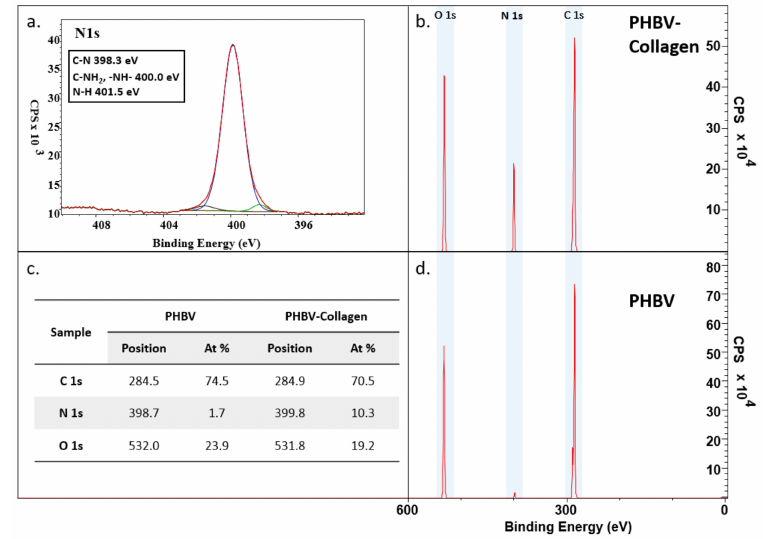
Figure 4. XPS analysis of PHBV and PHBV-Collagen fibre membranes: ( a ) a high-resolution view of the N 1 s peak observed upon conjugation of collagen; ( b ) spectra for PHBV-Collagen; ( c ) table of peak binding energies and the percentage of elements present; and ( d ) spectra for